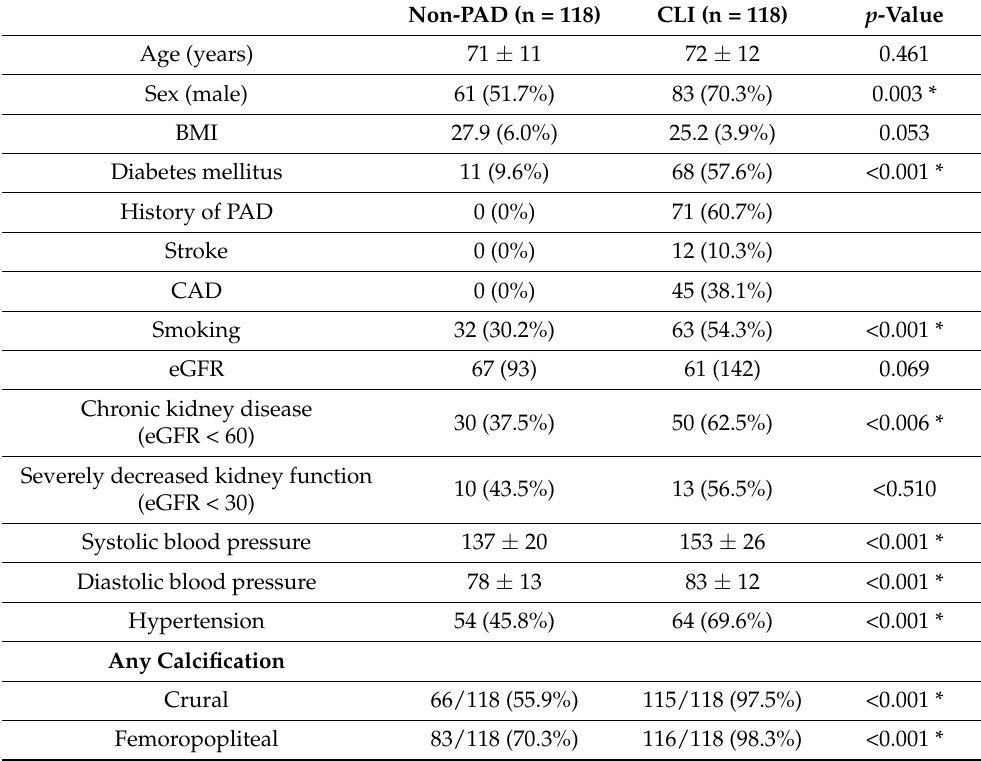
Table 1. Baseline variables of the age-matched CLI patients and the control non-PAD